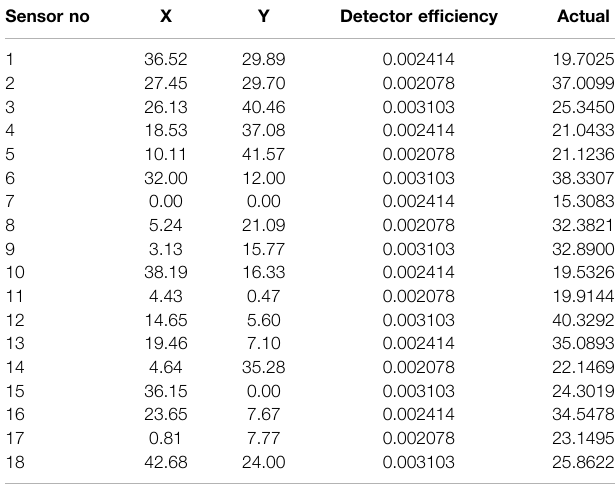
TABLE 1 | Sensors Coordinates used in 0.911 μ Ci Cs-137 Source Experiments and Actual measurements. Sensor no X Y Detector ef fi ciency Actual